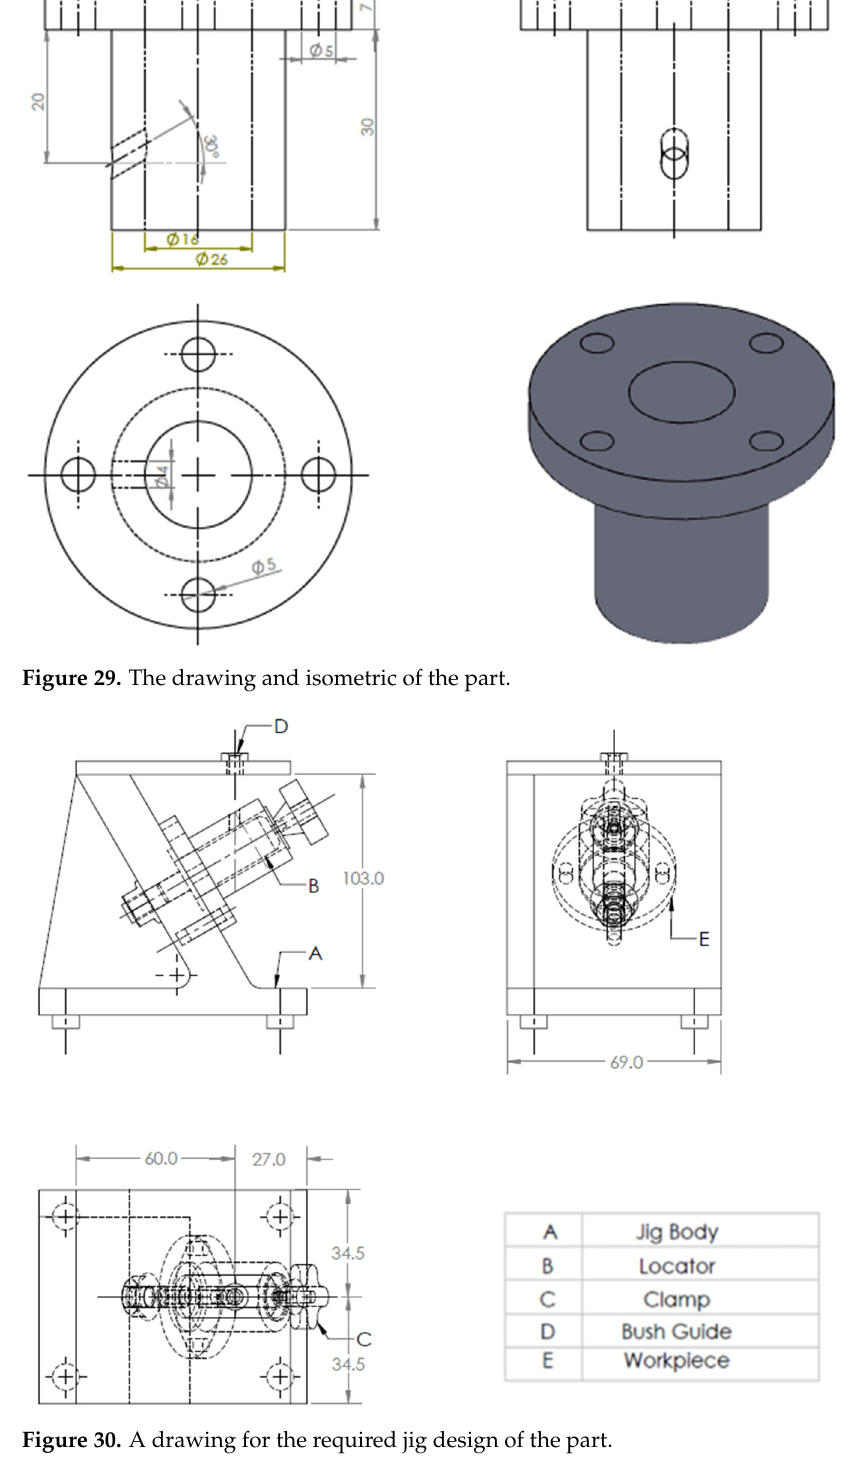
Figure 30. A drawing for the required jig design of the part.